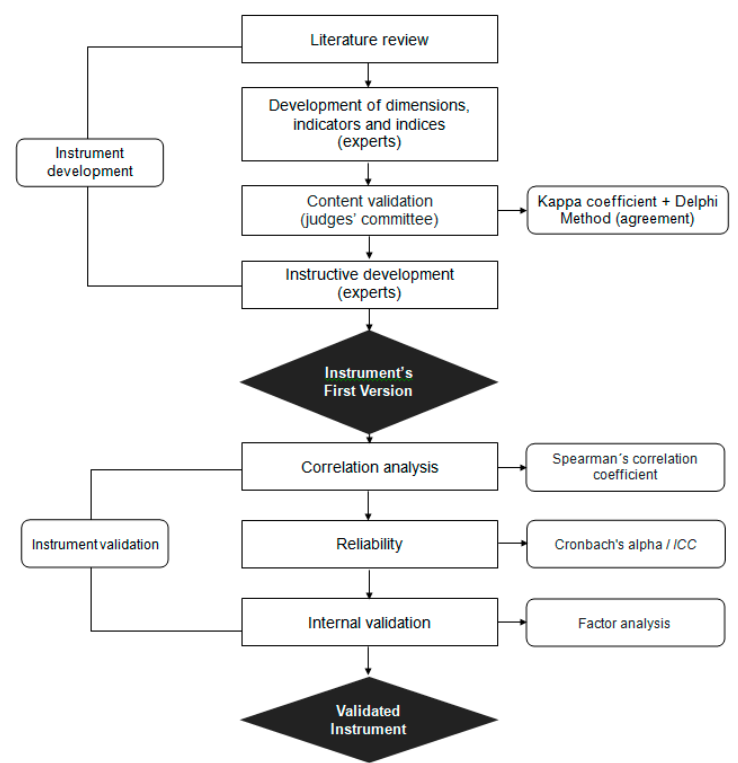
Figure 1. Interdisciplinary Worker’s Health Approach Instrument (IWHAI) development and validation